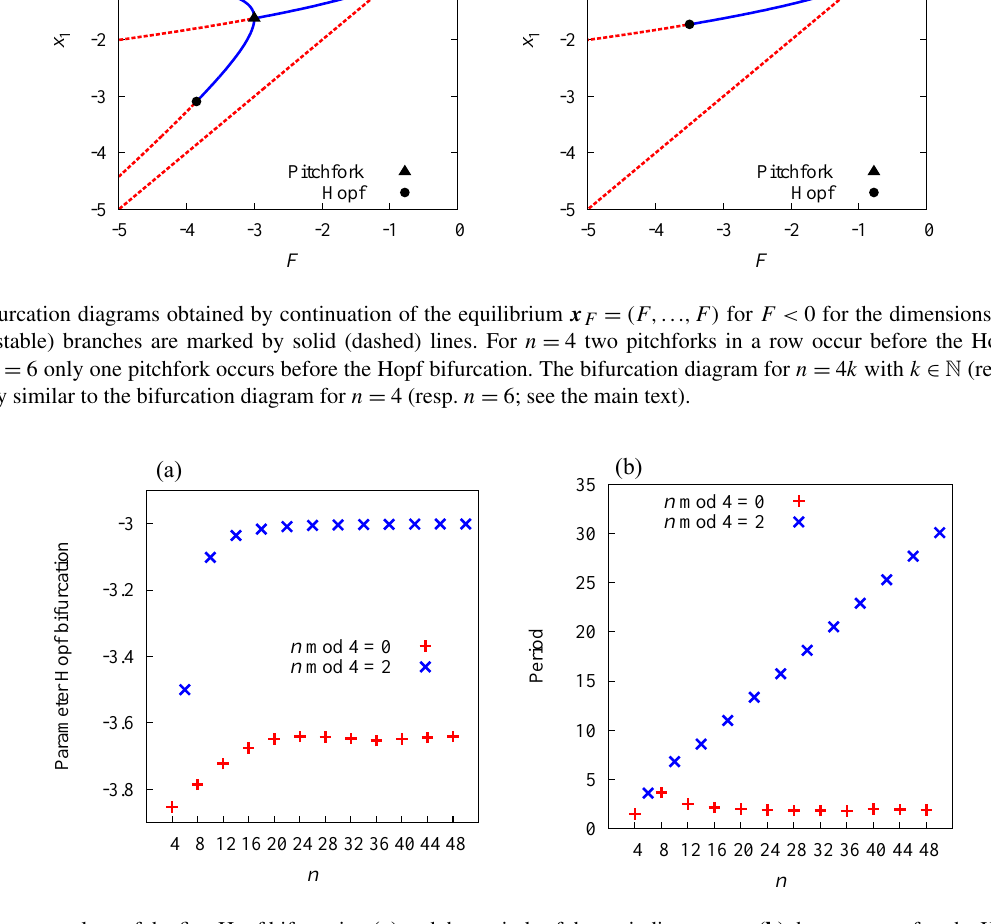
Figure 7. Parameter values of the first Hopf bifurcation (a) and the periods of the periodic attractor (b) that appears after the Hopf bifurcation for F < 0 and even values of the dimension n . For clarity the cases n = 4 k and n = 4 k + 2 have been marked with different symbols in order to emphasize the differences between the two